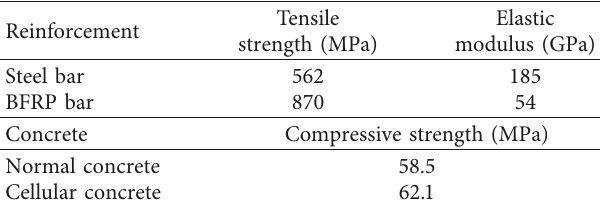
Table 4: Material